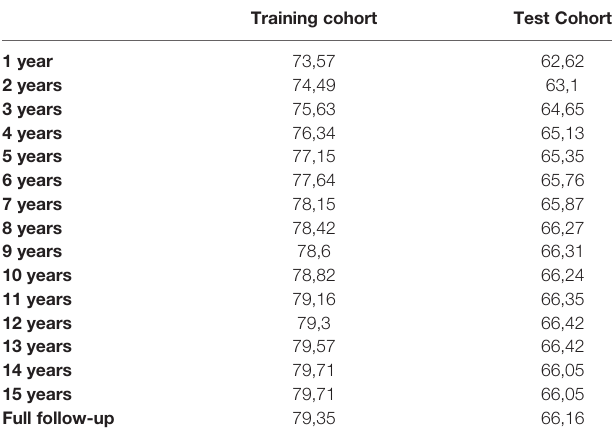
TABLE 2 | C-indexes of the predictions created by IAC-FL at different time points in the training and test sets. Training cohort Test